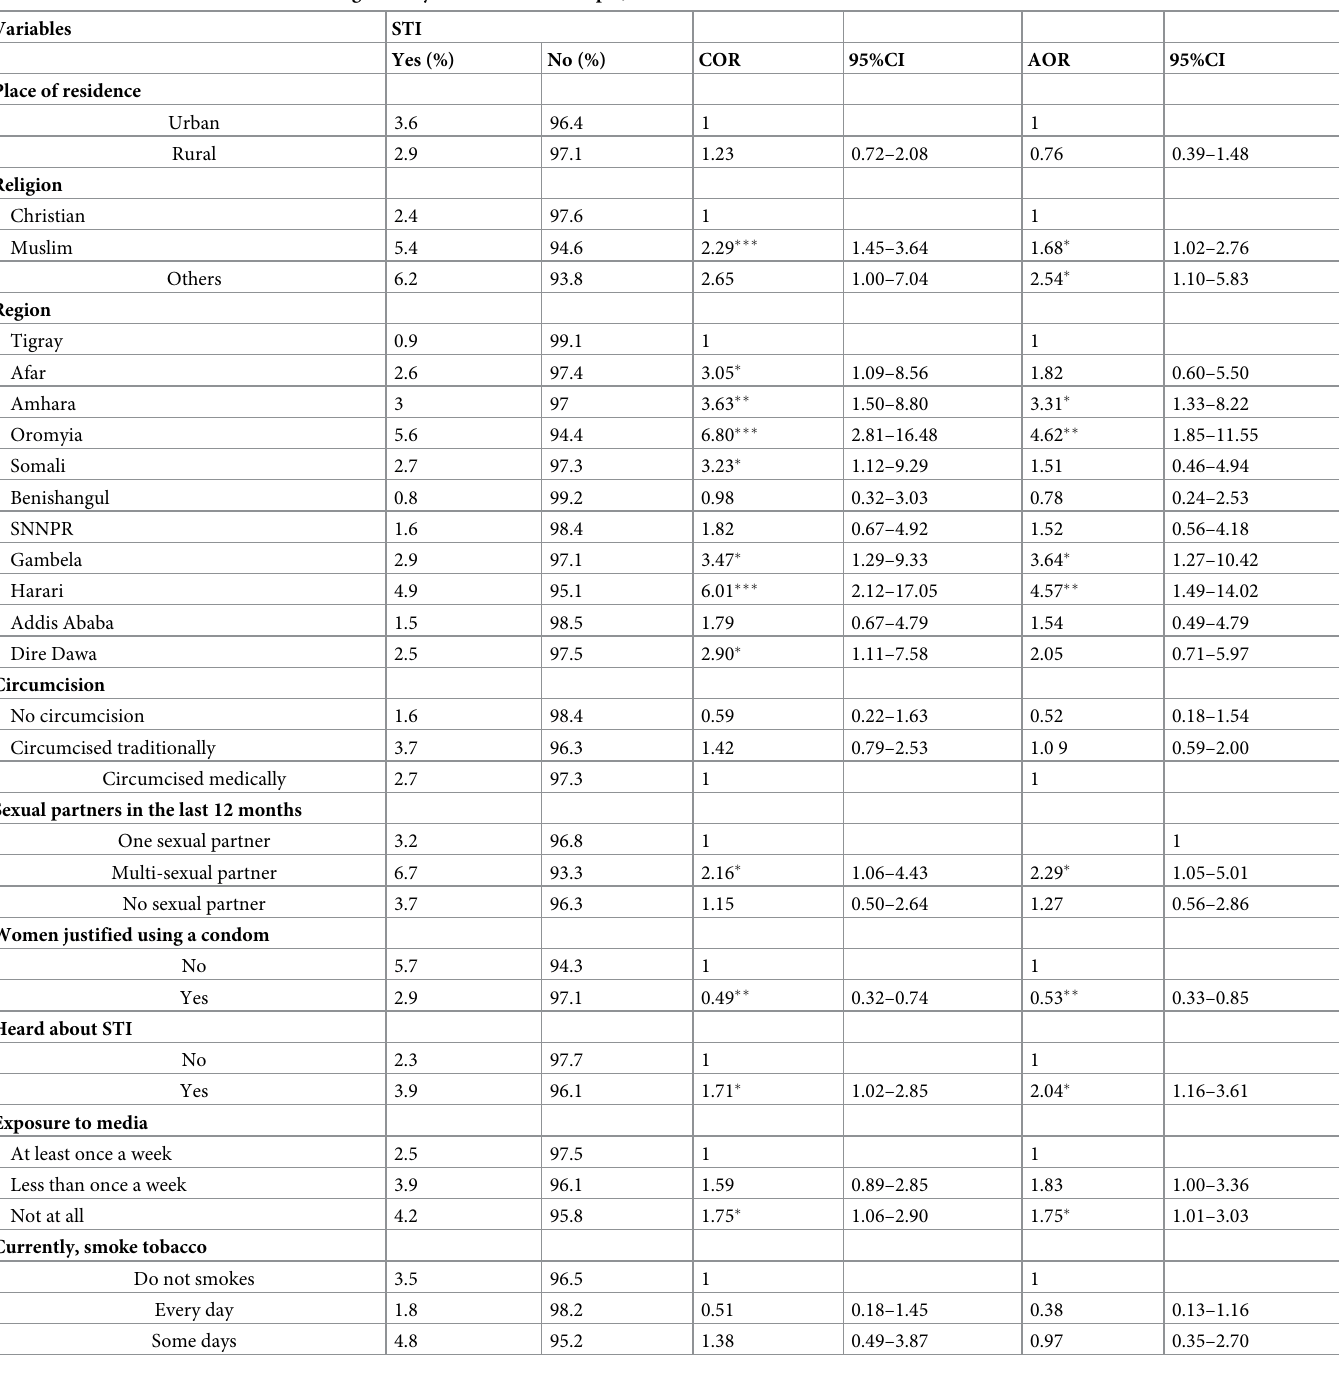
Table 4. Factors associated with STIs among sexually active men in Ethiopia; 2016